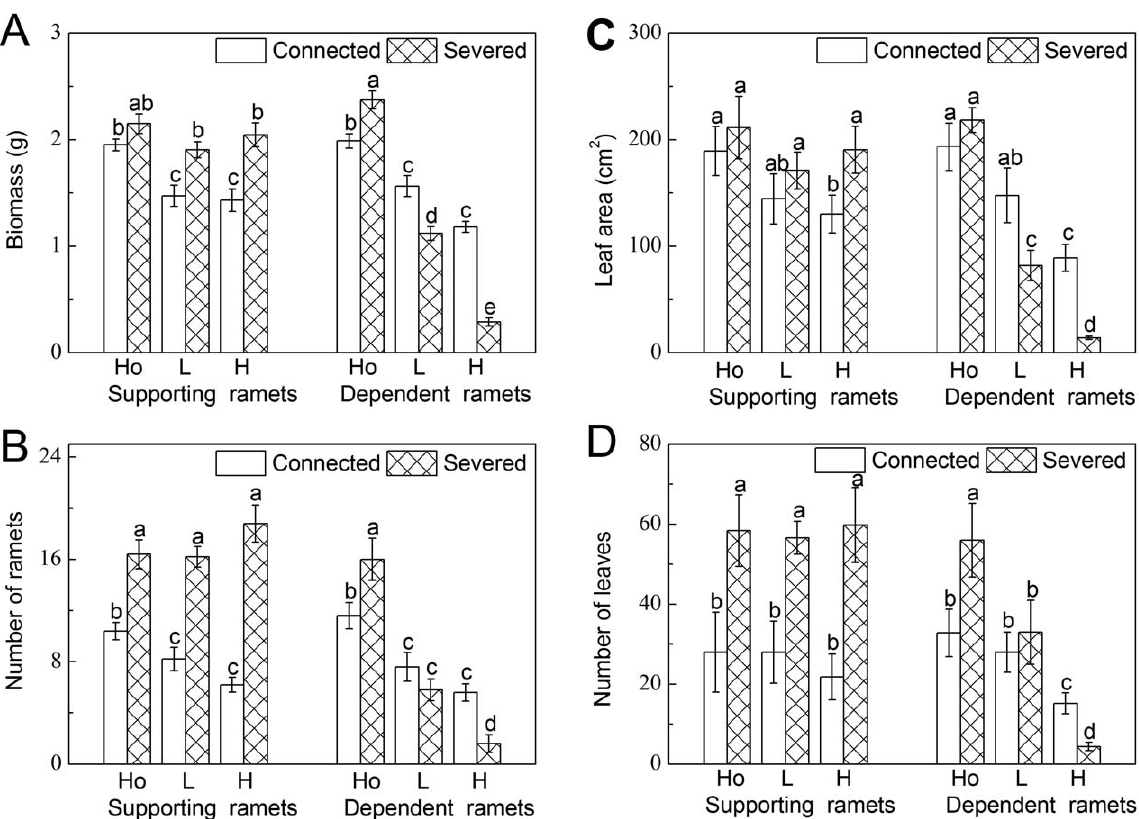
Figure 1. Growth parameters. (A) Biomass, (B) number of ramets, (C) leaf area, and (D) number of leaves of the supporting and the dependent ramets. Data are means 6 SE (n=15). Bars sharing the same lowercase letter are not different at p=0.05. Treatments are coded as in Table 1.